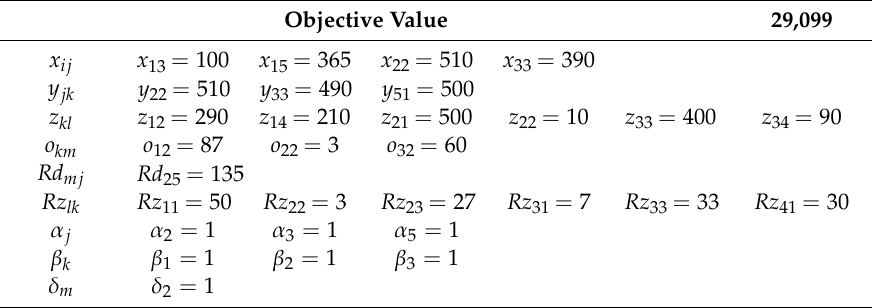
Table 8. The optimal solution of Experiment 2.